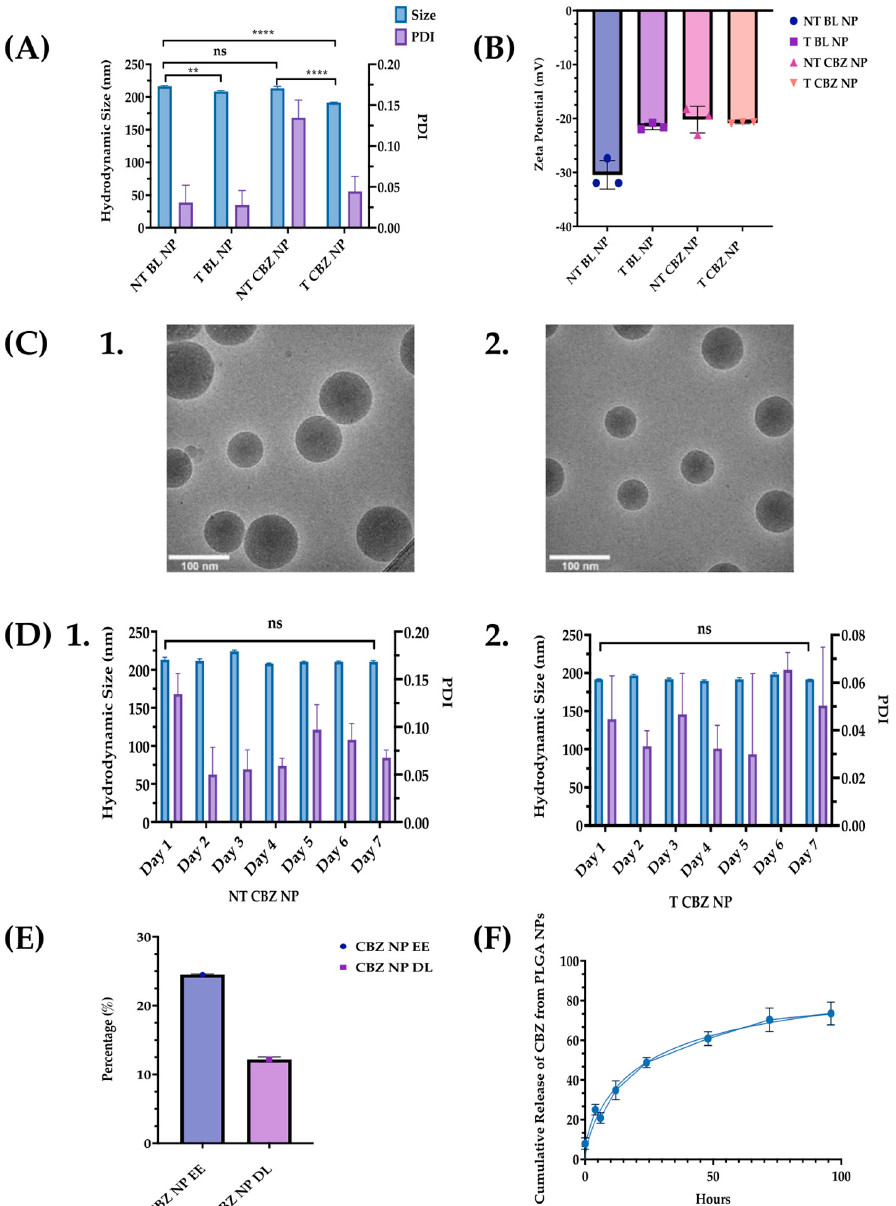
Figure 2. Nanoparticle size, PDI, Zeta Potential, and Cryo-TEM Images. ( A ) A graphical comparison of the size and PDI of non-targeted blank nanoparticles (NT BL NPs), targeted blank nanoparticles (T BL NPs), non-targeted Cabazitaxel-loaded nanoparticles (NT CBZ NPs), and targeted Cabazitaxel- loaded nanoparticles (T CBZ NP); Refer to Table S1 for summary of nanoparticle size, PDI, and ZP; ( B ) Zeta Potentials of the various nanoparticles ± SD; ( C ) Cryo-TEM Images of 1. NT NPs; 2. T NPs. Both nanoparticles are spherical with a relatively smooth surface and a unimodal size distribution. Particle size from cryo-TEM analysis was between 70 and 120 nm. ( D ) Stability of nanoparticles over a seven-day period. 1. NT CBZ NPs; 2. T CBZ NP. ( E ) Encapsulation Efficiency (% EE) was 24.5% and Drug Loading (% DL) of CBZ in PLGA nanoparticles ± SD was 12.195%; ( F ) Cumulative Release of CBZ versus time at pH 7.4 ± SD; A One-Way ANOVA followed by Tukey’s test was used to determine significance. Graphs created with GraphPad Prism 9.4.1. ns = not significant. ** p < 0.01, **** p < 0.0001 (n = 3).